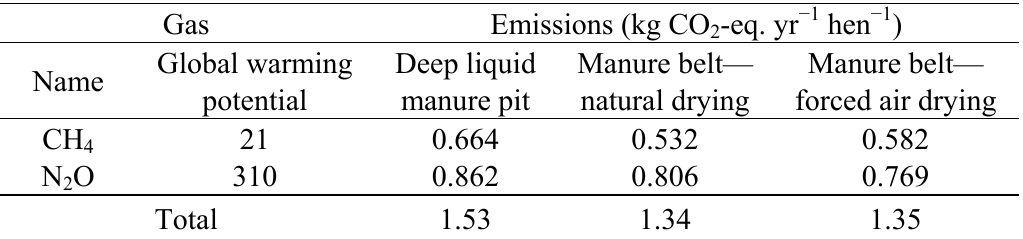
Table 5. Greenhouse gas emissions from the three housing